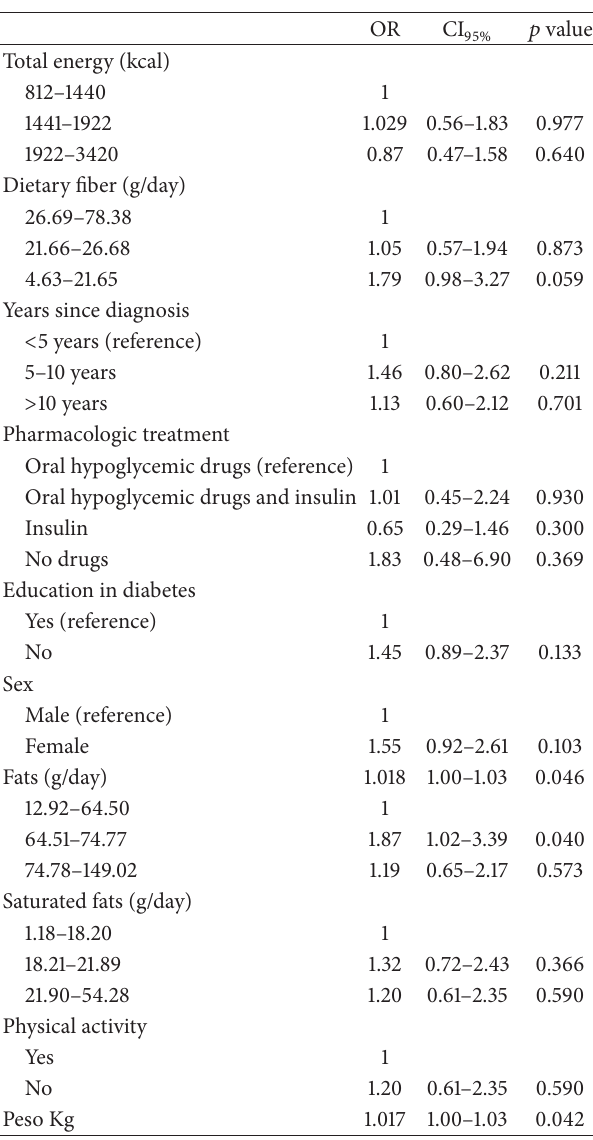
Table 6: Odds ratios (OR) and 95% confidence intervals (CI 95 % ) derived from a multivariate logistic regression model to identify the risk of an inadequate